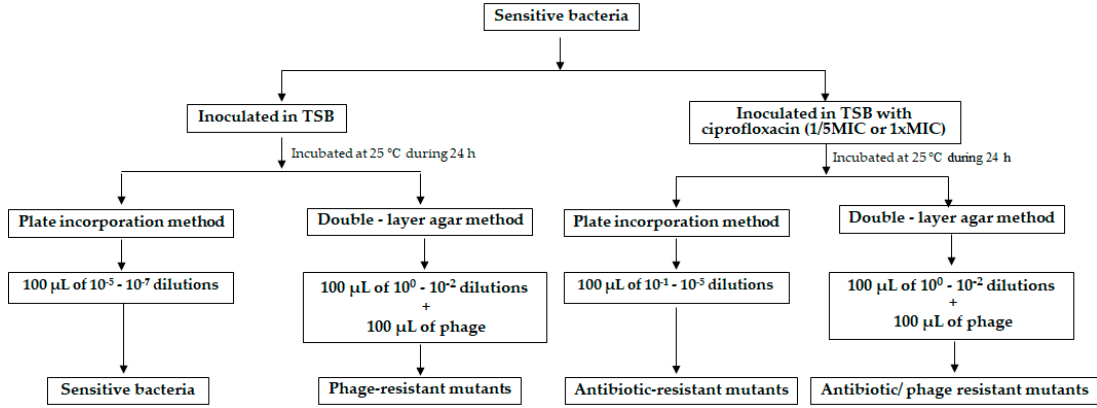
Figure 1. Design of the experimental work to test the emergence of bacterial resistances .